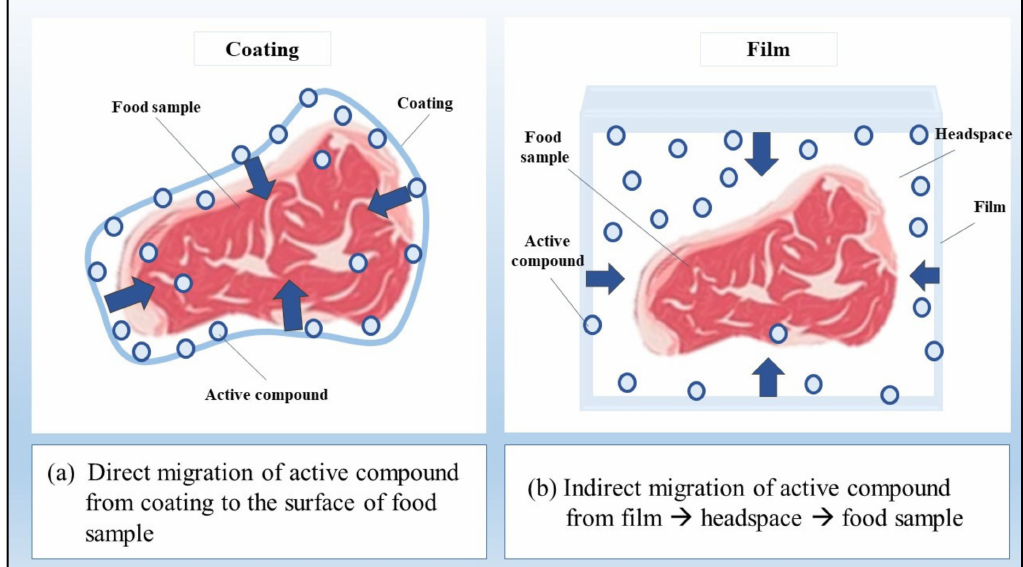
Figure 2. The mechanism of active compound migration from ( a ) coating and ( b )